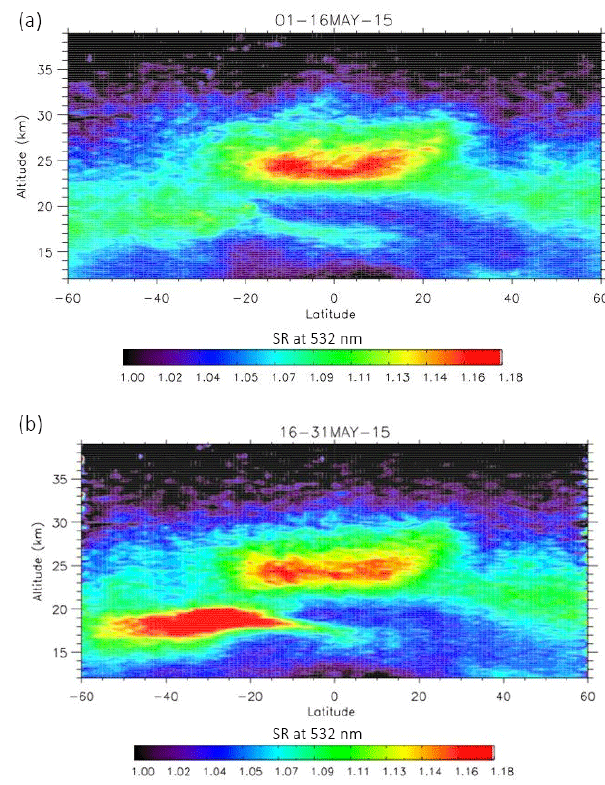
Figure 4. Half monthly mean of the zonal scattering ratio at 532nm on (a) 1–15 May (1–2 weeks after eruption) and (b) 16–31 May (3–4 weeks after